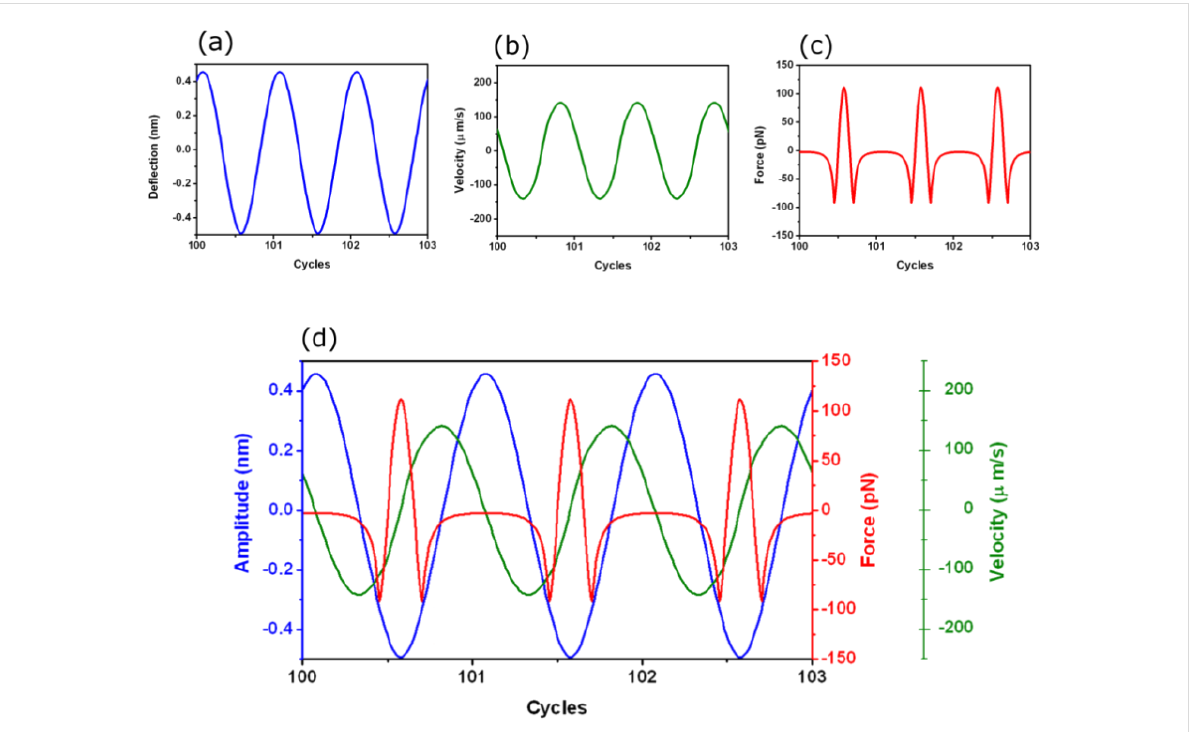
Figure 2: dForce simulation of AM-AFM for a tip–surface force that includes van der Waals and DMT. (a) Instantaneous tip deflection. (b) Instanta- neous velocity. (c) Instantaneous force. (d) Combining different plots in a single figure. Deflection (blue), velocity (green) and force (red). The simula- tions were performed for z c = 0.5